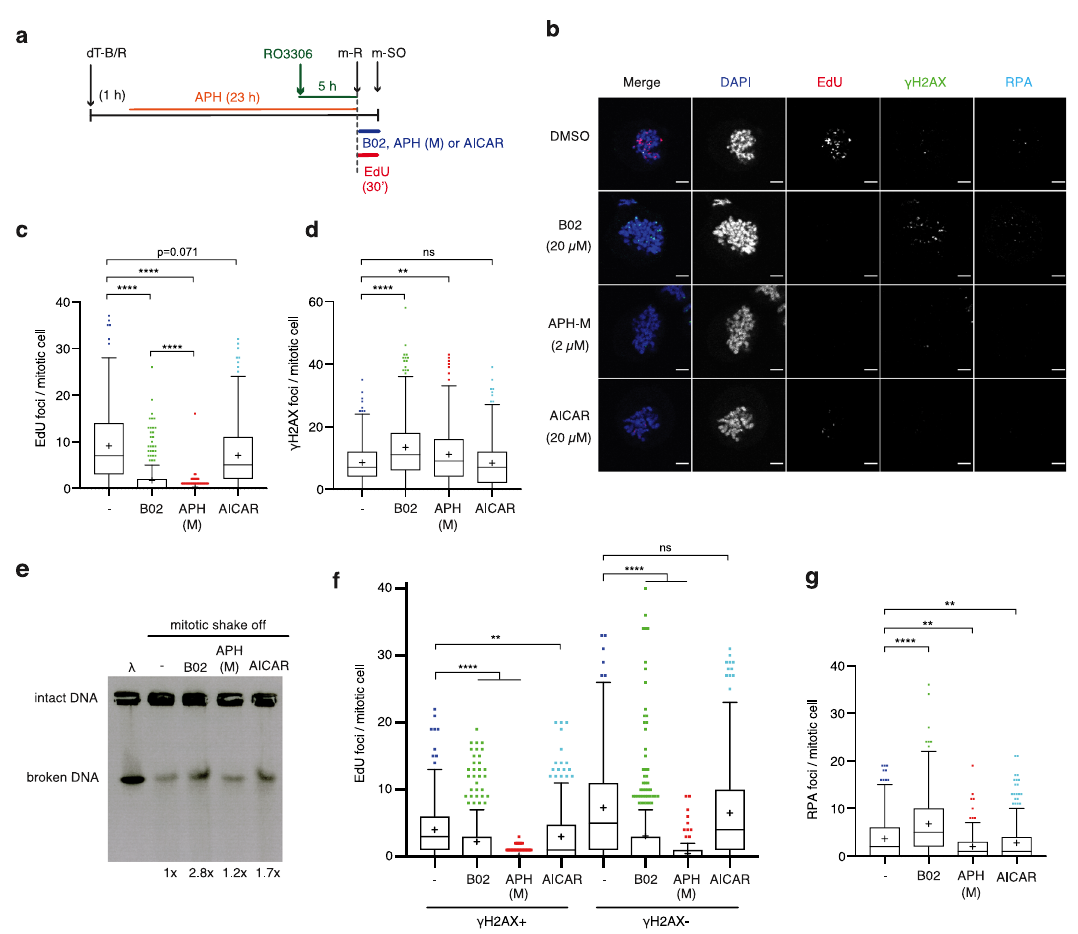
Fig. 3 RAD51 depletion in mitosis induces DNA breakages. a Schematic diagram of experimental procedure in which U2OS cells were synchronised in the presence of low-dose APH and exposed to vehicle (-) or small molecule inhibitors of RAD51 (B02), B-family polymerases (2 µ M APH (M)) or RAD52 (20 µ M AICAR) upon mitotic release (m-R). b Representative images of mitotic cells collected by mitotic shake-off (m-SO), following 10 µ M EdU exposure with or without indicated small molecule inhibitors, stained for EdU incorporation and γ -H2AX and RPA. Scale bar indicates 5 µ m. c , d . Quanti fi cation of the number of EdU foci ( c ) and γ -H2AX foci ( d ) per mitotic cell. Data were obtained from three independent experiments (100 cells analysed per repeat); n = 300 per condition. Data distribution is represented by Tukey box-and-whisker plots. Bounds of box are 25 – 75th percentile, centre shows the median and ‘ + ’ marks the mean. Whiskers indicate ±1.5xIQR, data outside this range are drawn as individual dots. p- values were calculated by a Kruskal – Wallis test followed by Dunn ’ s multiple comparison test. Asterisks indicate ** p -value ≤ 0.01; **** p -value ≤ 0.0001. e Pulsed- fi eld Gel Electrophoresis (PFGE) of mitotic cells, collected by m-SO, after synchronisation and the indicated drug treatments upon m-R. DNA fragments of 1 – 100 kb size were separated by electrophoresis. Lambda ( λ ) DNA ladder was used as DNA size standard. Total band intensity was normalised to untreated (-) control (Quanti fi cation). Based on a single experiment. f Quanti fi cation of the number of EdU foci that colocalise with γ -H2AX ( γ -H2AX + EdU foci) and the number of EdU foci that do not colocalise with γ -H2AX ( γ -H2AX - EdU foci) per mitotic cell. Data were obtained from three independent experiments (100 cells analysed per repeat); n = 300 per condition. Data distribution is represented by Tukey box-and-whisker plots. Bounds of box are 25 – 75th percentile, centre shows the median and ‘ + ’ marks the mean. Whiskers indicate ±1.5xIQR, data outside this range are drawn as individual dots. p- values were calculated by a Kruskal – Wallis test followed by Dunn ’ s multiple comparison test. Asterisks indicate ** p -value ≤ 0.01; **** p -value ≤ 0.0001. g Quanti fi cation of the number of RPA foci per mitotic cell. Data were obtained from three independent experiments (100 cells analysed per repeat); n = 300 per condition. Data distribution is represented by Tukey box-and-whisker plots. Bounds of box are 25 – 75th percentile, centre shows the median and ‘ + ’ marks the mean. Whiskers indicate ±1.5xIQR, data outside this range are drawn as individual dots. p- values were calculated by a Kruskal – Wallis test followed by Dunn ’